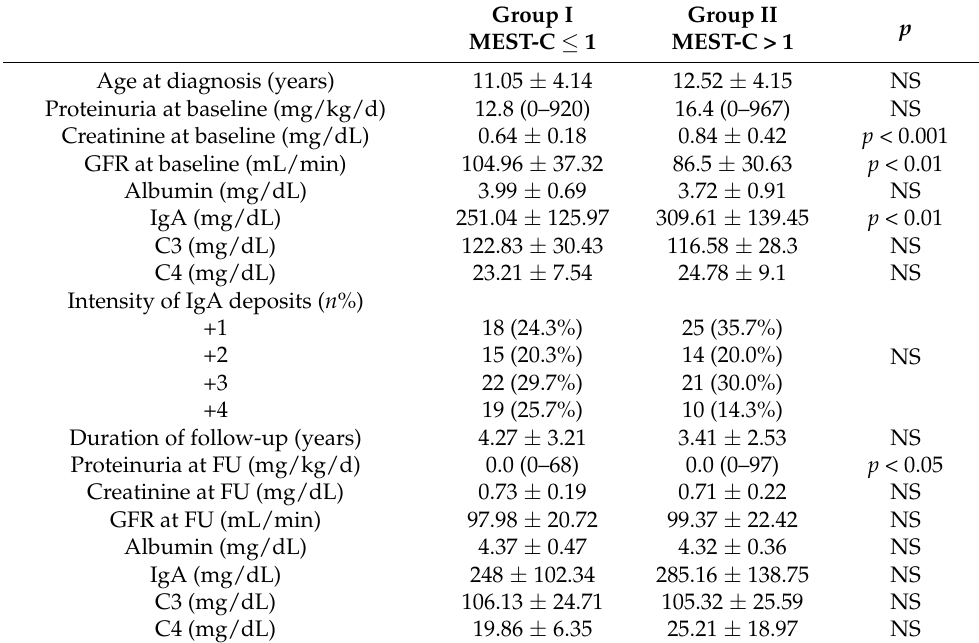
Table 3. Clinical characteristics of the patient groups based on the MEST-C